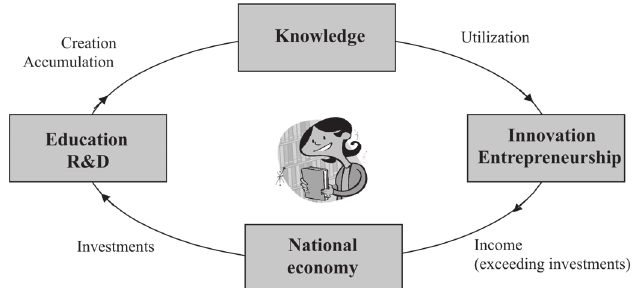
Fig 3. Knowledge for development: turnover and positive feedback